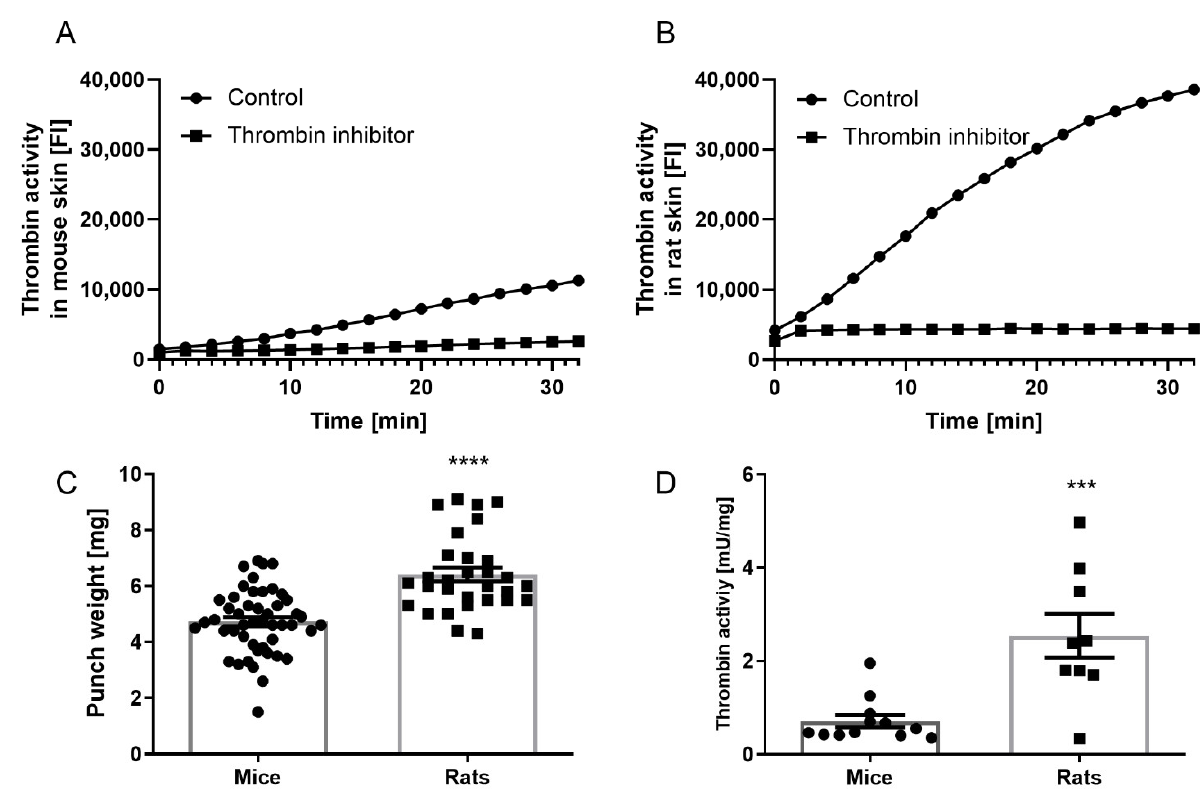
Figure 2. Thrombin activity in healthy mice and rats: representative graphs of measurable thrombin activity that was detected in mice ( A ) and rat ( B ) skin. This activity was fully inhibited by a specific thrombin inhibitor. ( C ) Biopsy weight was significantly lower in mice (n = 30) compared with in rats (n = 48). ( D ) Normalized thrombin activity was significantly higher in rats’ skin (n = 9) compared with in the mice skin (n = 12). Results are presented as mean ± SEM, *** p = 0.0004, **** p < 0.0001. Scale bar—100 µ